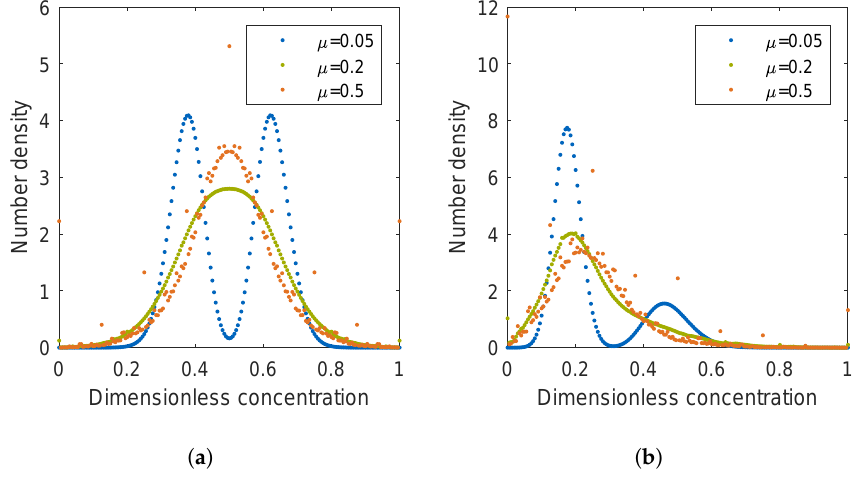
2 for three different values of the convergence 0 10